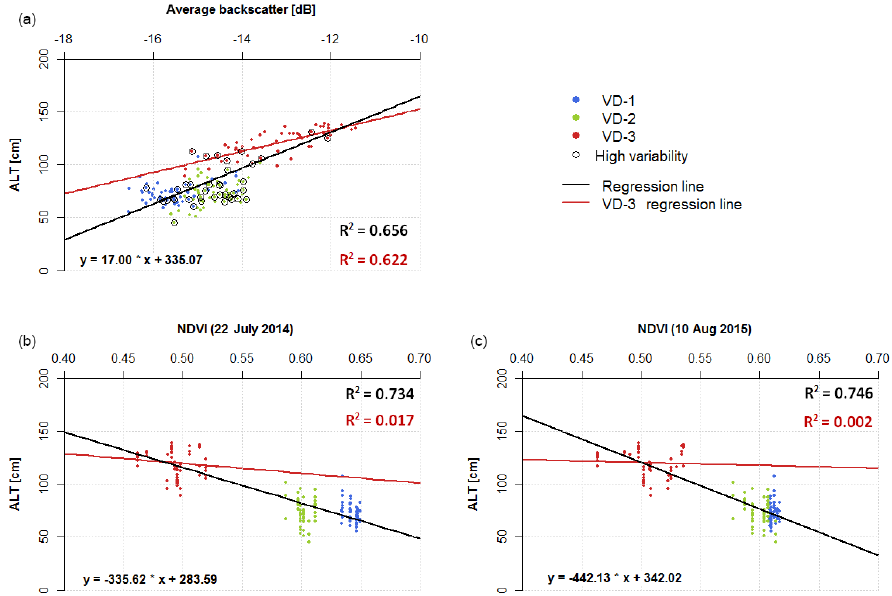
Figure 5. Upper left: comparison between σ 0 and ALT values at the sites VD-1 to VD-3. Points with differences of more than 1dB between 2014 and 2015 are marked by circles. Linear regression for σ 0 and ALT values of all sites in black and for site VD-3 in red. Bottom: comparison between NDVI (22 July 2014 and 10 August 2015) and ALT values at the sites VD-1 to VD-3. Linear regression for NDVI and ALT values of all sites in black and for site VD-3 in